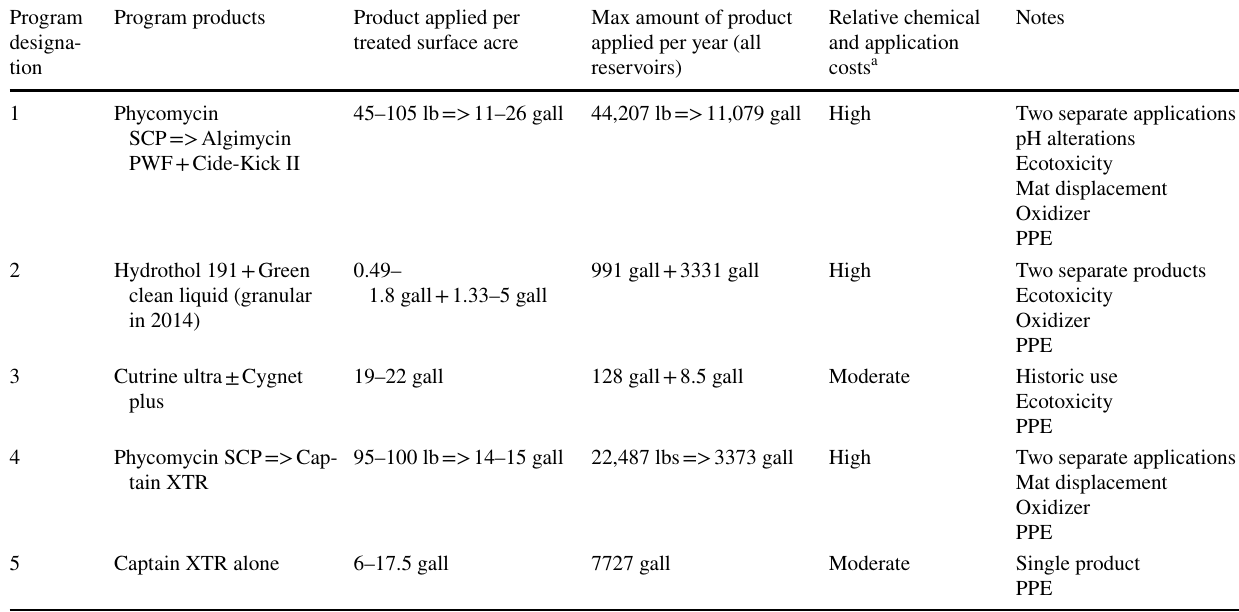
Table 2 Description of L. wollei treatment programs used on the three Alabama reservoirs from 2013 to 2018